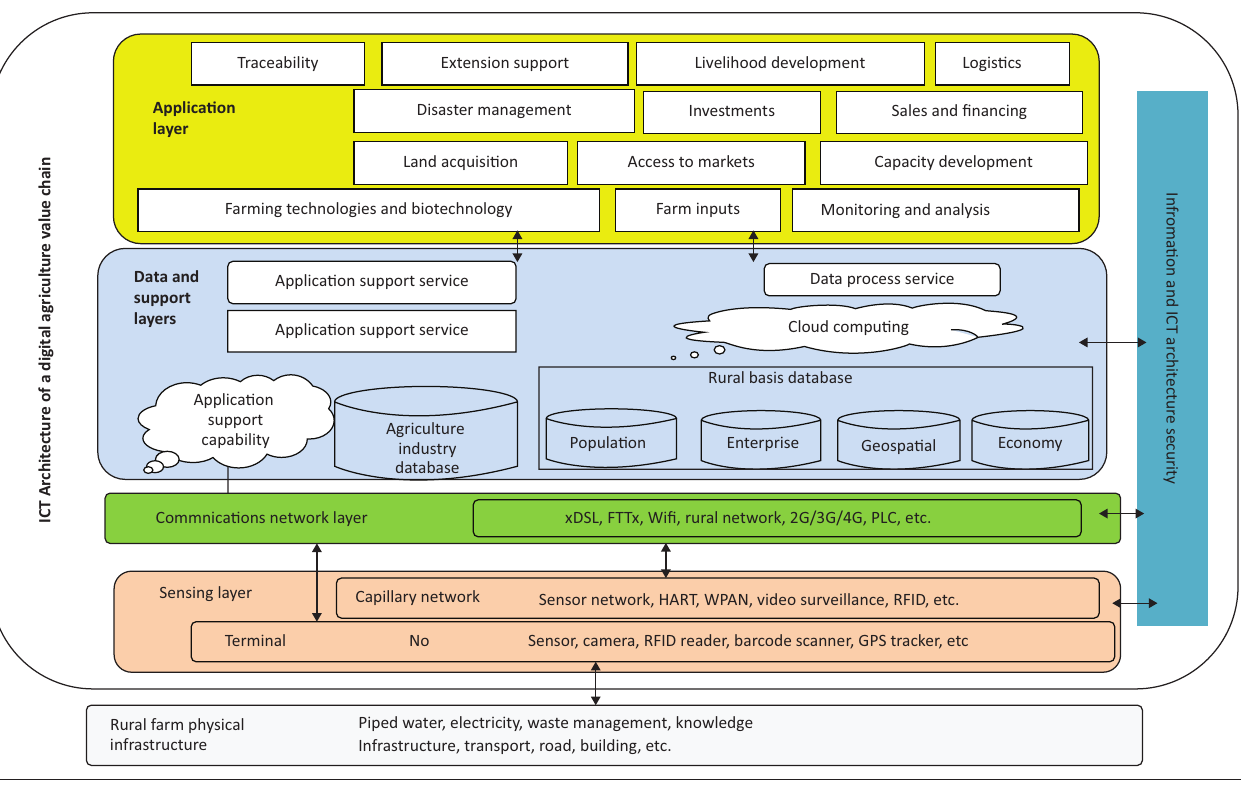
FIGURE 11: Digital agriculture value chain